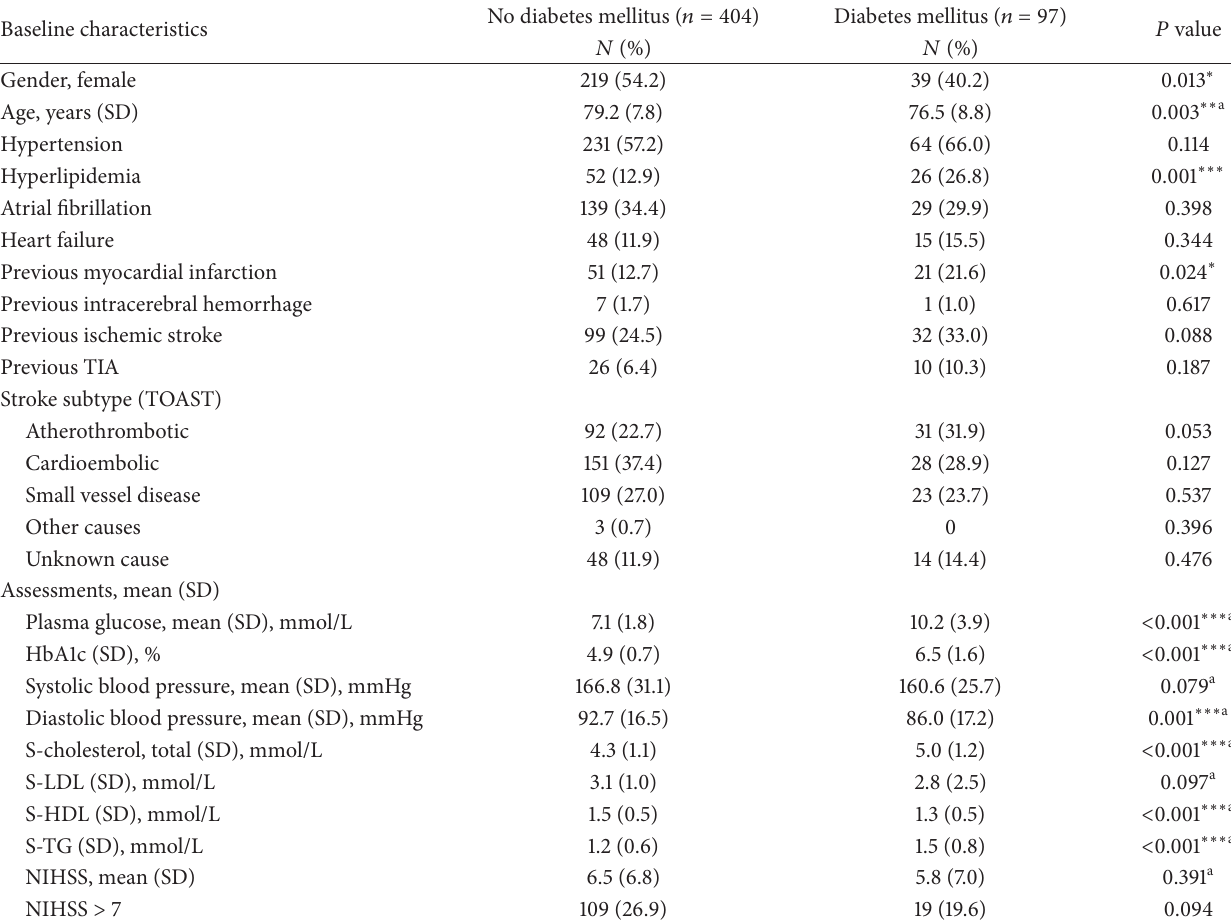
Table 1: Patients’ characteristics at baseline ( 𝑁 = 501 ) by presence of diabetes